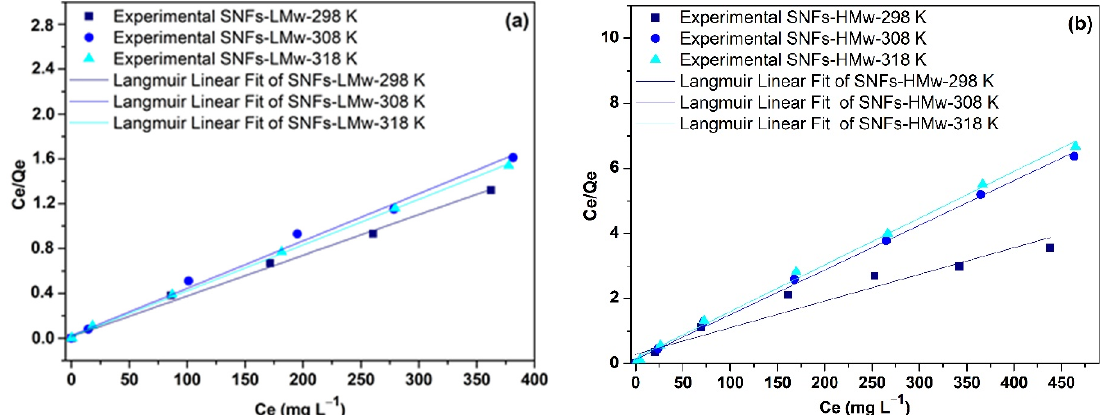
10 of 17 Figure 5. Effect of initial MB concentration and temperature: ( a ) SNFs-LMw and ( b ) SNFs-HMw. Error bars represent standard deviations of triplicate tests. Table 3 shows the results obtained from the adsorption parameters derived accord- ing to the linear forms of the two models (Equations (3) and (4)). The statistical parameters were also explored to identify the fit quality of each model. The best fit model was chosen based on the highest correlation coefficients ( R 2 ) and the lowest SD and RMSE values. Comparing the results, the adsorption of MB on both adsorbents was best fit by the Lang- muir isotherm. Figure 6a,b show the experimental and Langmuir linear fit (best fit model) obtained when Ce/Qe was plotted against Ce at 298 K, 308 K and 318 K for SNFs-LMw